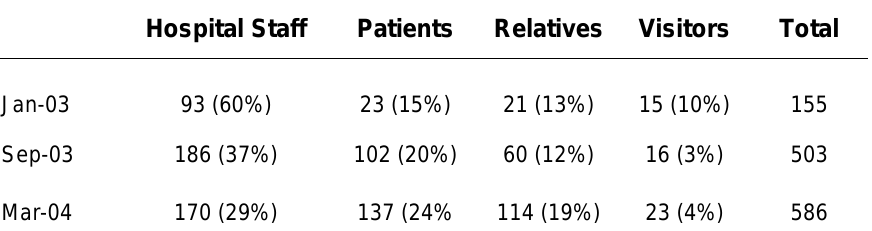
Aggregated Service